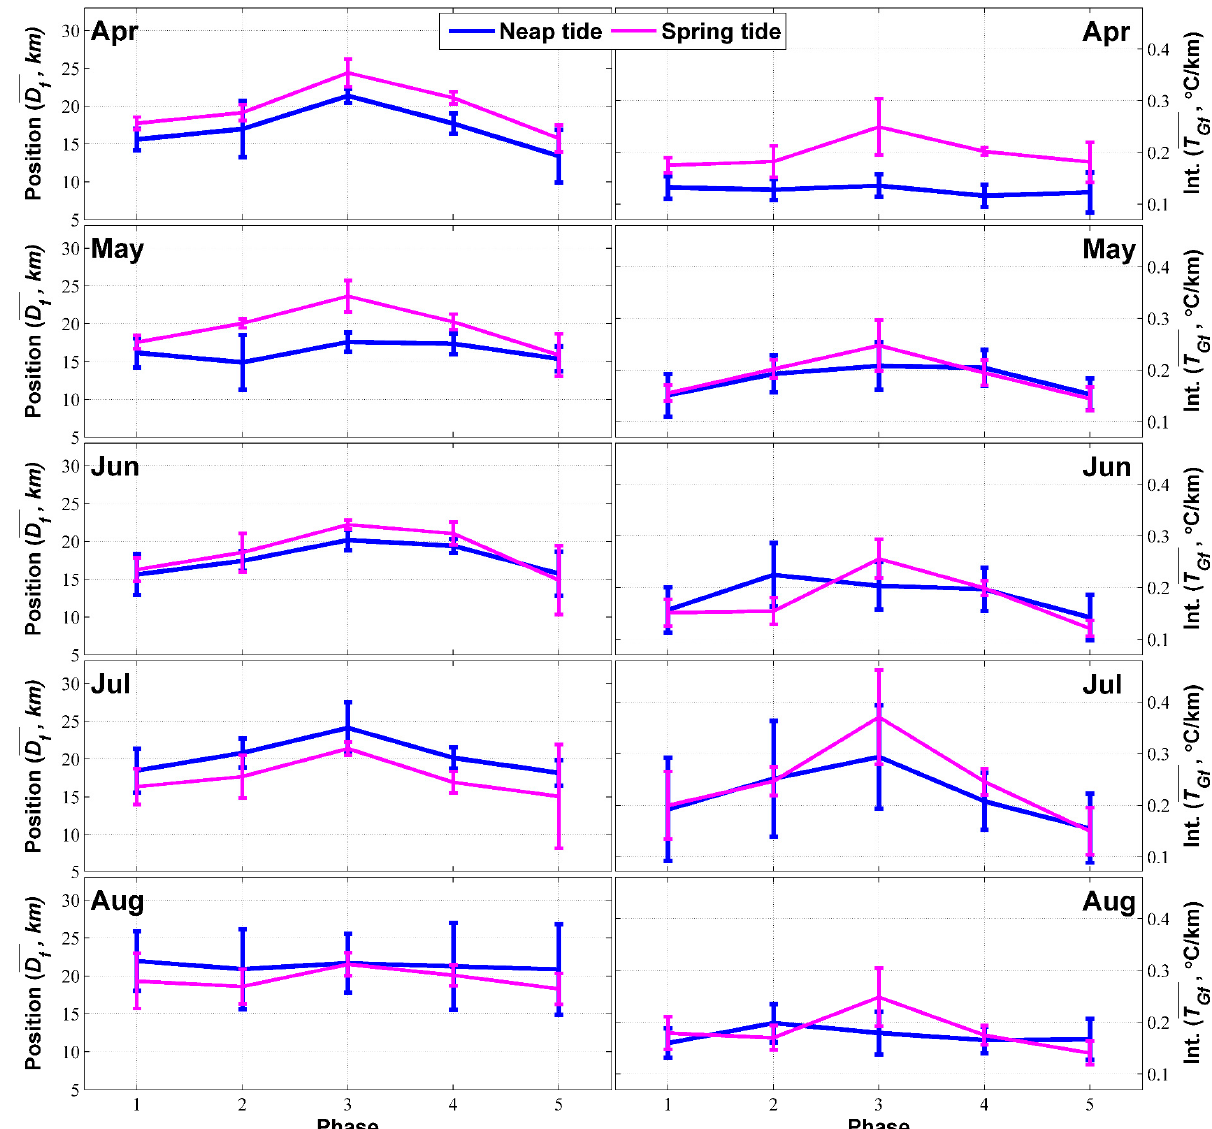
Figure 10. Five points on the pink and blue lines (spring tide and neap tide, respectively) represent the spatially averaged position ( D f , , top left panel) and intensity ( T Gf , top right panel) of the temporally averaged tidal front shown as a thick black line in Figures 8b–f and 9b–f, respectively. The bar is the standard deviation of the spatially averaged position and the spatially averaged intensity ( left and right , respectively). The other panels correspond to the monthly results of May to August after the same data processing.